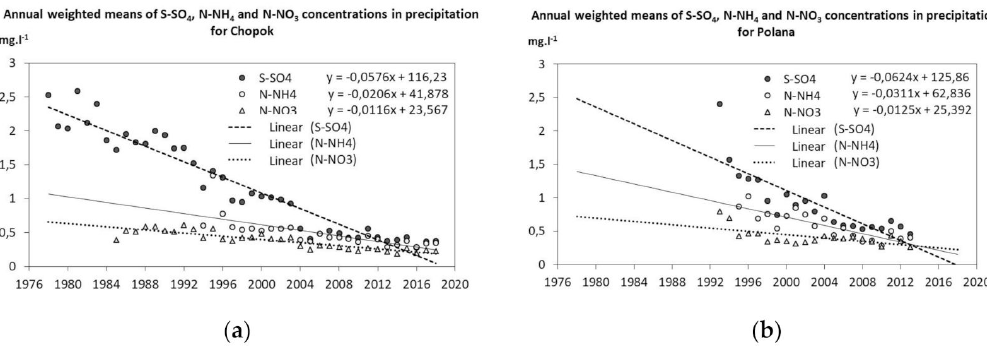
Figure 5. Annual mean weighted concentrations of acidic elements (S-SO 42 − , N-NH 4 + , and N-NO 3 − ) in precipitation: ( a ) Chopok, ( b )